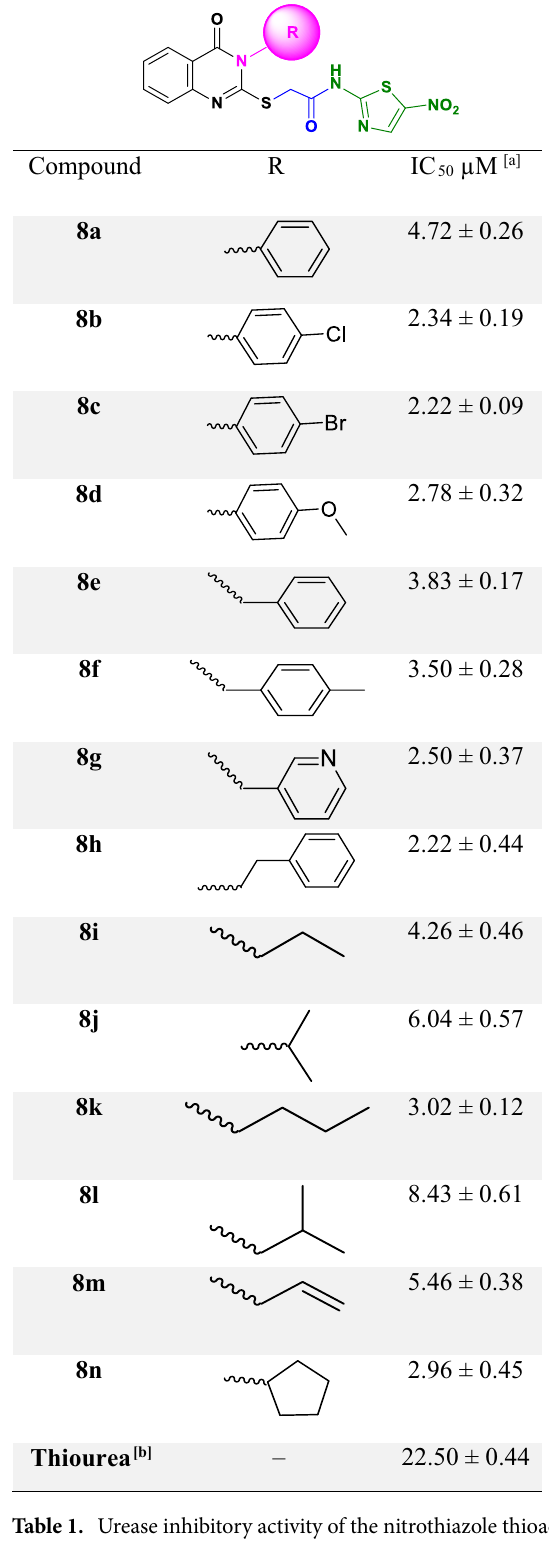
Table 1. Urease inhibitory activity of the nitrothiazole thioacetamide containing different quinazolinone moieties. a IC 50 values are expressed as mean ± standard error of three independent experiments. b Standard inhibitor of